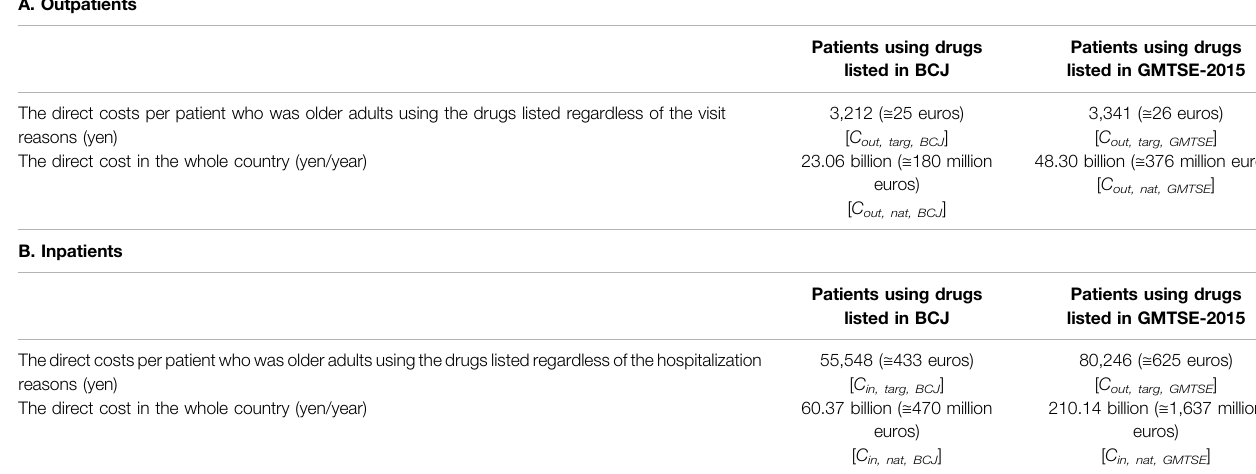
TABLE 7 | Direct costs of avoidable adverse drug events in older